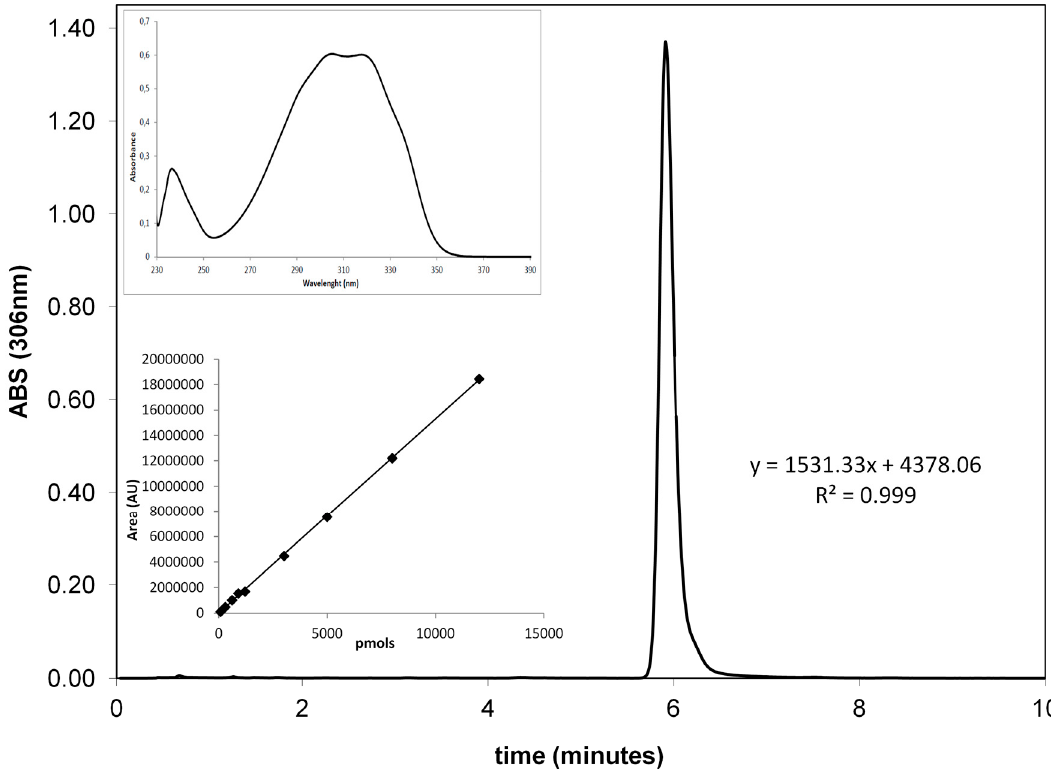
Figure 8. Resveratrol determination and quantitation. Resveratrol representative HPLC chromatogram. Figure 8 . Resveratrol determination and quantitation. Resveratrol representative HPLC Inset: resveratrol UV-visible (UV-Vis) absorption spectrum as registered by photodiode array detector chromatogram. Inset: resveratrol UV-visible (UV-Vis) absorption spectrum as registered by and calibration curve. The curve was obtained by plotting the resveratrol amount injected onto the photodiode array detector and calibration curve. The curve was obtained by plotting the resveratrol HPLC and its peak area at 306 amount injected onto the HPLC and its peak area at 306 nm.